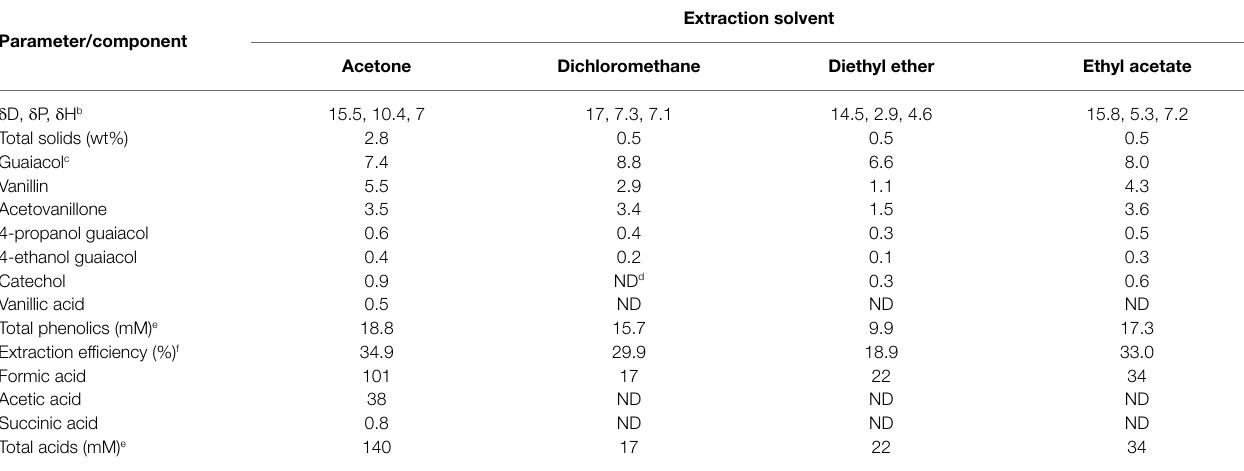
R. rhodochrous strains ( Figure 1 ) based on the nucleotide sequence of their 16S rRNA genes, ANI, and phylogenetic placement (Chaumeil et al., 2019). The 16S rRNA genes (27F- 1492R; Lane, 1991) of GD01 and GD02 shared 100% sequence identity with that of R. rhodochrous EP4 (Levy-Booth et al., 2019). More generally, the GD01 and GD02 genomes were very closely related to each other, with an ANI of 99.1%, as well as to 5.72 Mb genome of EP4 (ANI TABLE 1 | Components of Lignoforce ™ industrial black liquor (BL) filtrate from mixed softwood species a . Extraction solvent Parameter/component Acetone Dichloromethane Diethyl ether